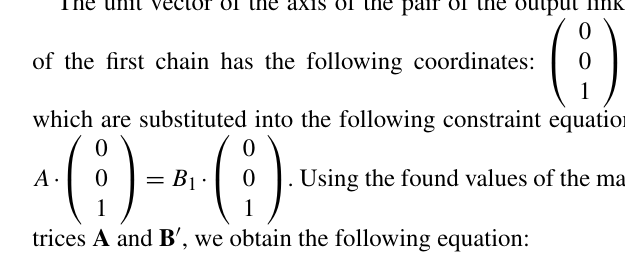
which are matrices of additional rotations for aligning the moving and stationary coordinate system around the z and x axes by tje angles ξ 11 , and ξ 12 , respectively, with ξ 11 = 90 ◦ , and ξ 12 = 90 ◦